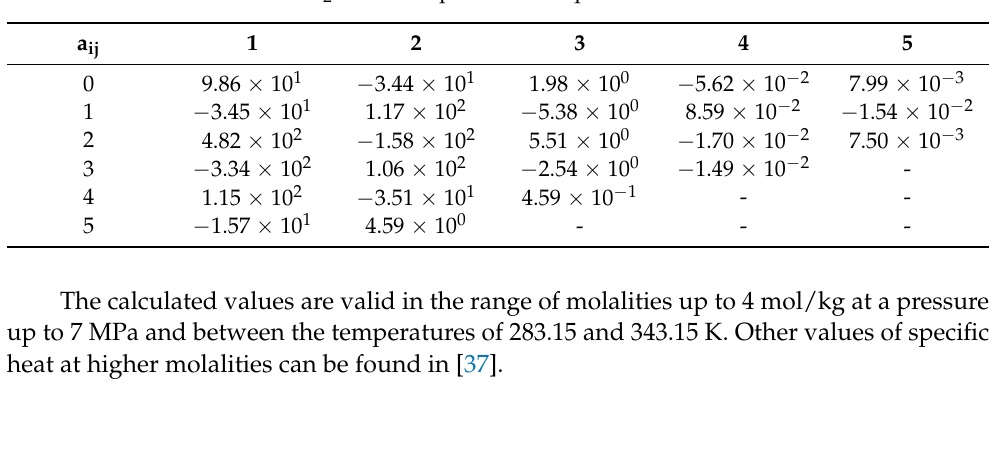
Table A30. Coefficients of the H 2 O-NaOH specific heat